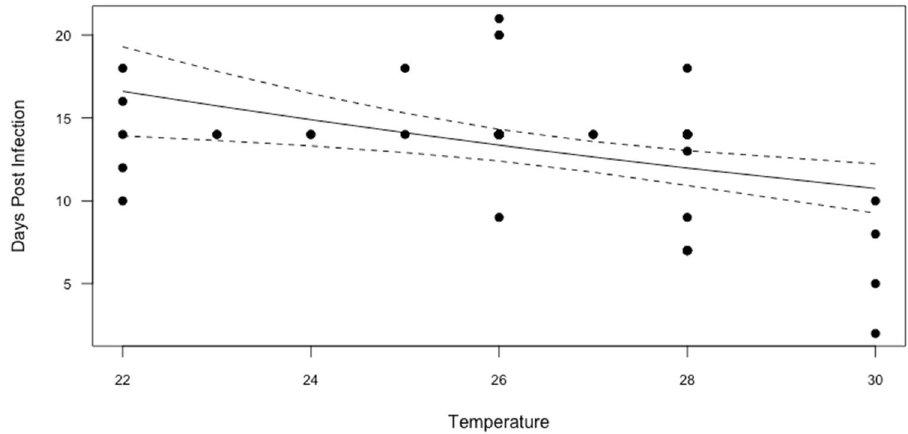
Figure 4. Relationship between temperature and Days Post Infection for WNV strain NY99.